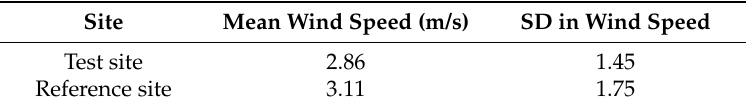
Table 2. Characteristics of the measured wind speed for the training year 2016.